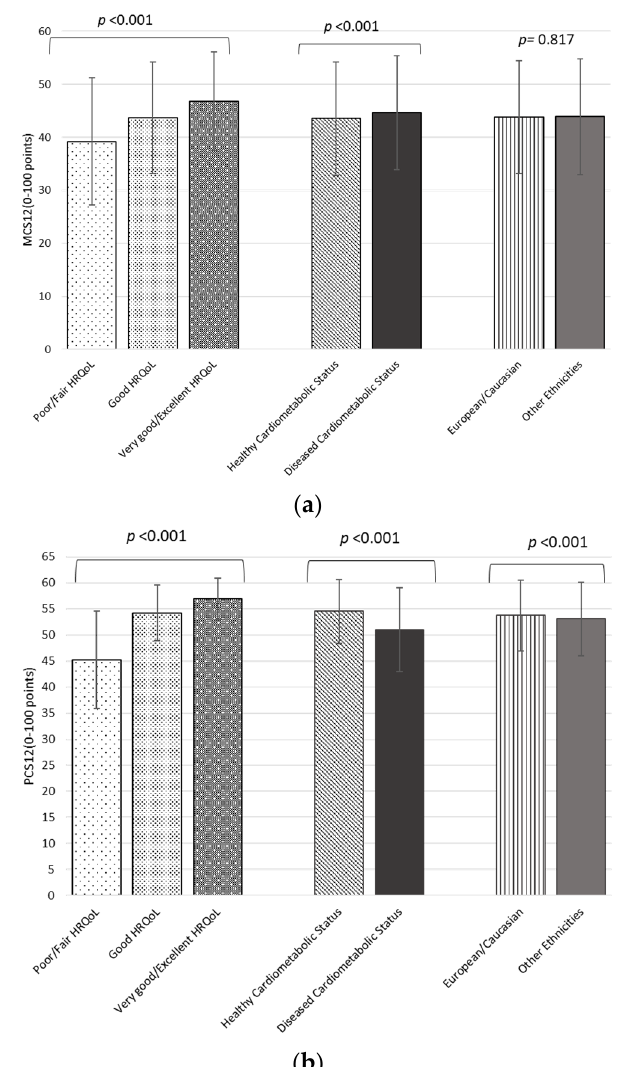
Figure 2. Mental ( a ) and Physical ( b ) Component Summary Score of SF-12 Health Survey Categorized by Cardiometabolic Health Status and Ethnicity.